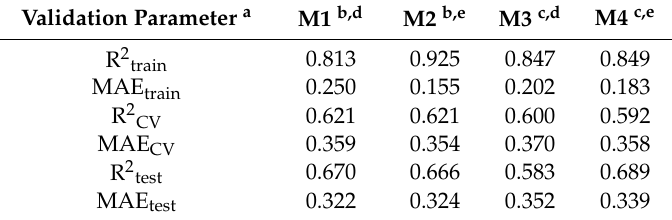
Table 3. Statistical performance of machine learning